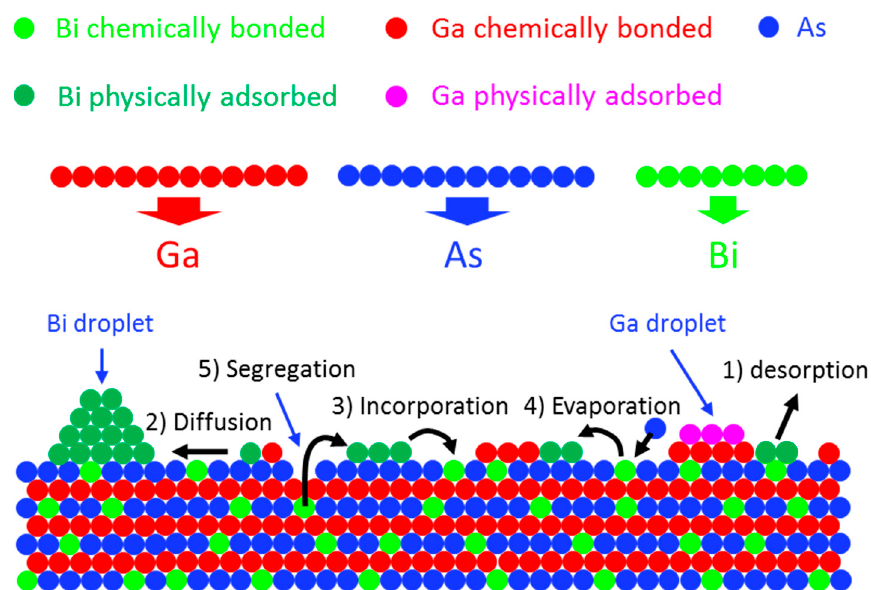
Figure 2. Schematic illustration of various physical processes of Bi atoms (surface is not fully covered with Bi adatoms).